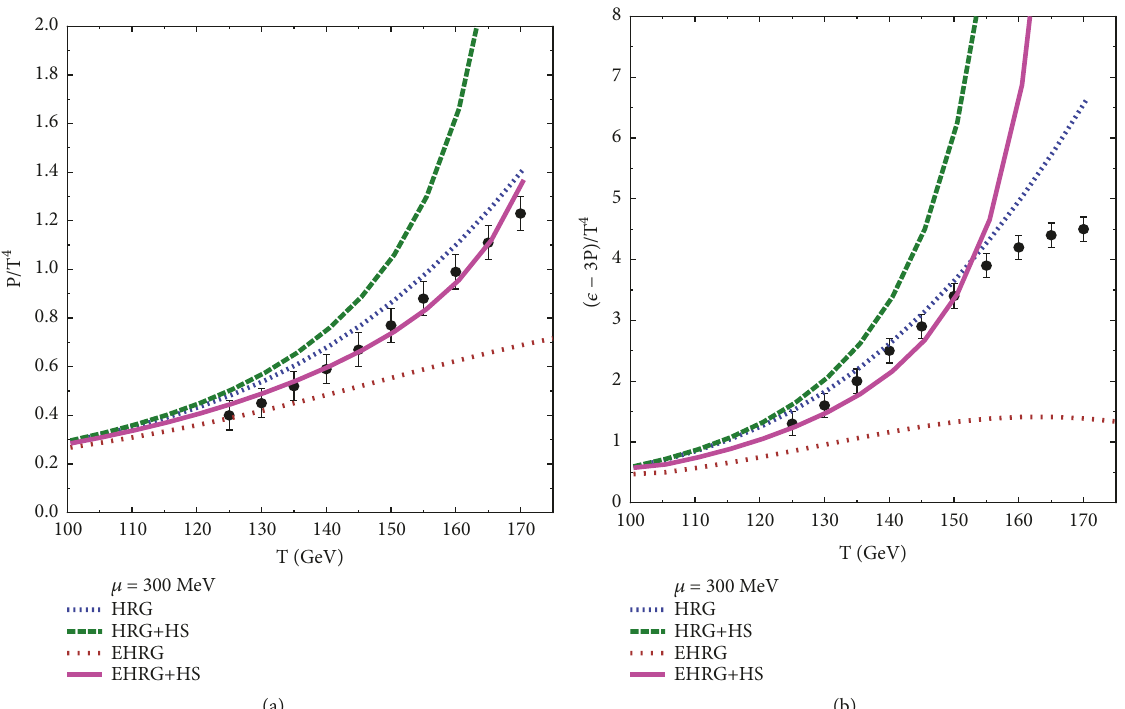
Figure 2: Thermodynamical functions, pressure(a)and traceanomaly (b),atfinitechemicalpotential.The hard-coreradius of all thehadrons has been set to the value 𝑟 ℎ = 0.4 fm. The LQCD data has been taken from [42].